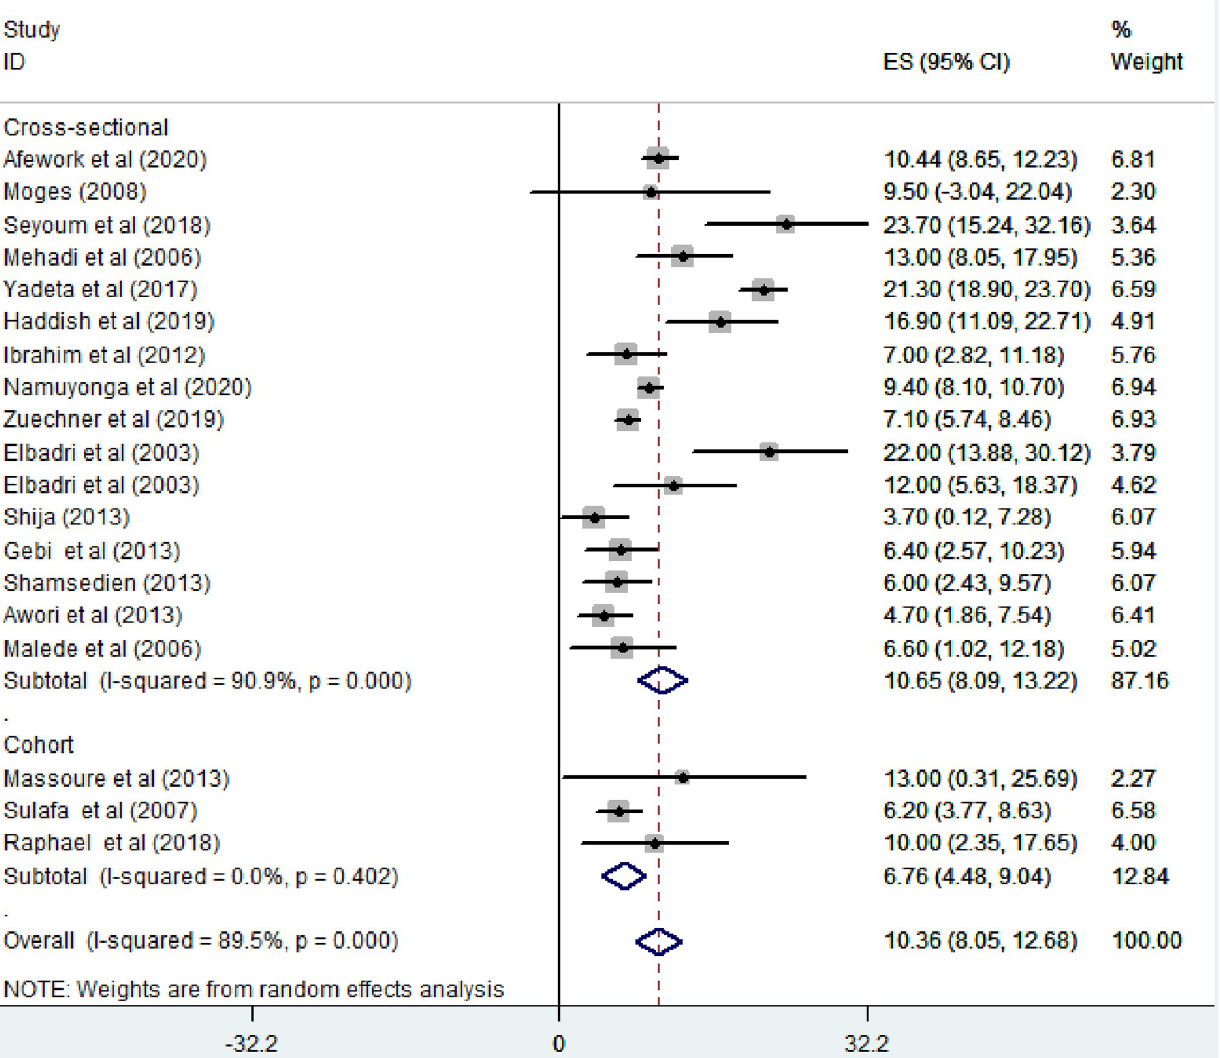
Fig 9. Forest plot showing the subgroup analysis of the prevalence of atrial septal defect among congenital heart defect patients by Study design in East Africa, from January 2000-October 2020.